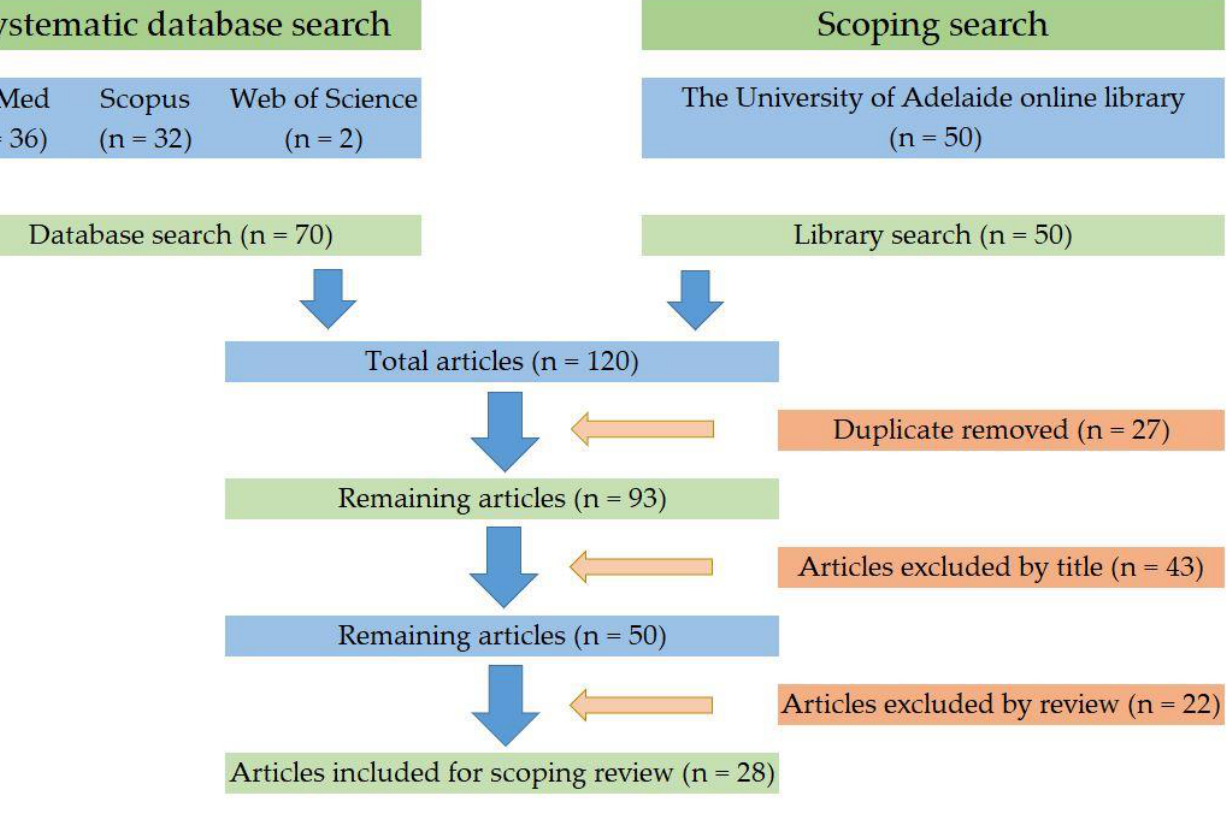
Figure 1. PRISMA diagram summarizing literature search.